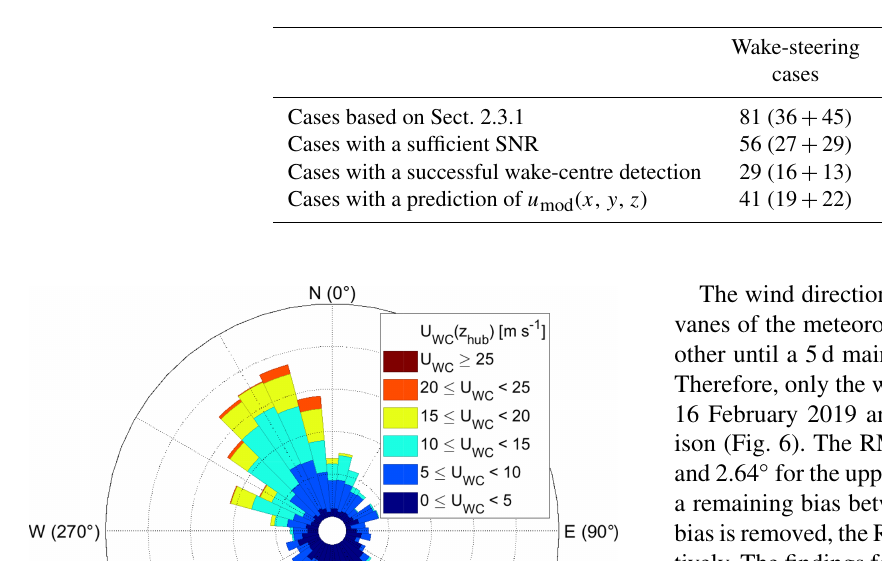
Table 1. Overview of wake-steering cases (middle column) and control cases (right column). From top to bottom: the number of 30min periods that met the requirements of Sect. 2.3.1, the number of cases with a sufficient SNR of the wake-scanning lidar, the number of cases with a successful detection of the wake centre based on the correlation threshold (Sect. 2.3.3), and the number of cases for which the model prediction of u mod ( x , y , z ) was possible (Sect. 2.4). The numbers outside of the brackets are the total cases, and the numbers inside the brackets are the 2D scans and 3D scans of the wake-scanning lidar, respectively.